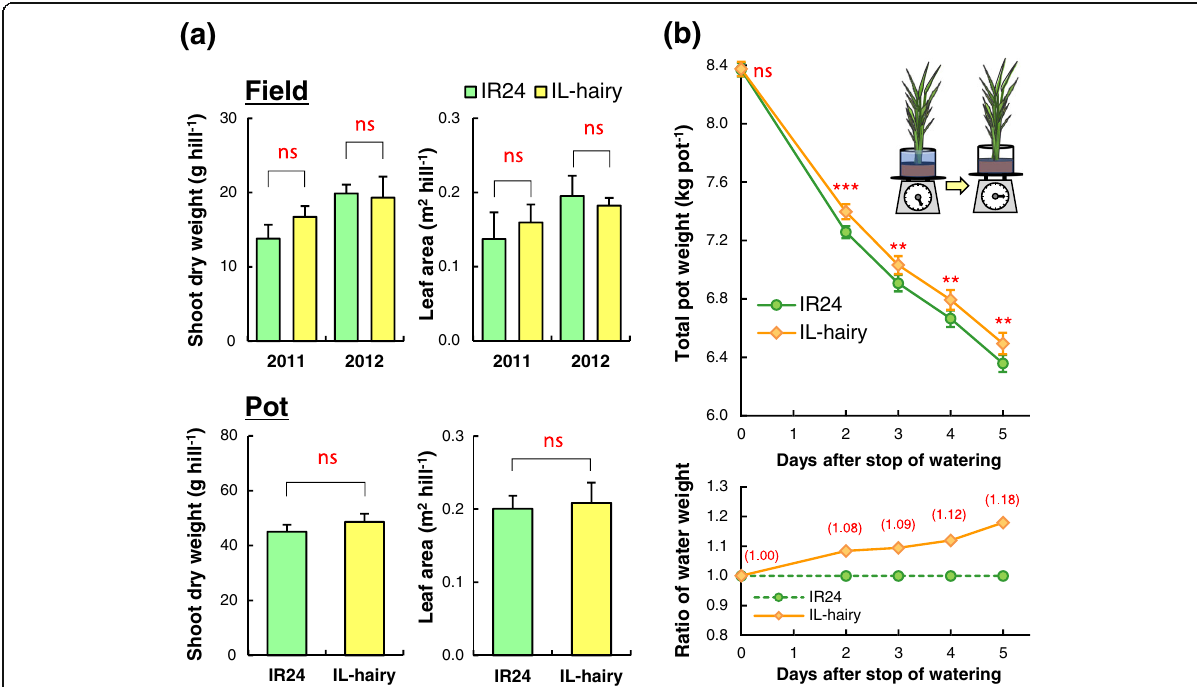
Fig. 5 Shoot dry weigh, leaf area, and water uptake traits of the whole plant. a Shoot dry matter production and leaf area in the field ( vegetative stage ) and pots ( heading stage ). Data are means ± SD (field, n = 3; pot, n = 4). ns, not significantly different ( t -test). b Changes of total pot weight including plant weight and ratio of water weight of IL-hairy relative to that of IR24 during 5 days after stop of watering at the booting stage. Data are means± SD ( n = 7). ** P = 0.01, *** P = 0.001; ns, not significantly different ( t -test). Values in parentheses show relative values of IL-hairy to